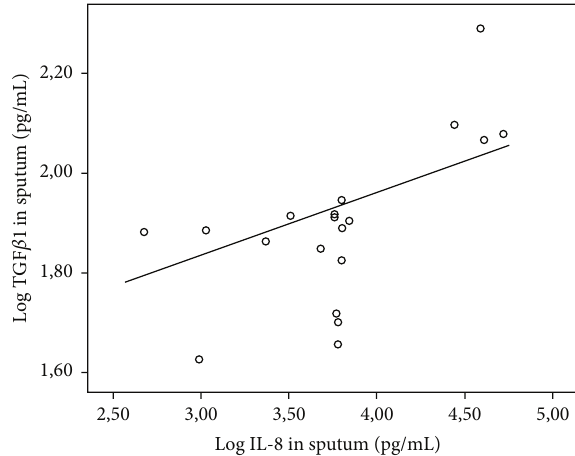
Figure 1: Log 10 TGF 𝛽 1 (pg/mL) in induced sputum in CF patients colonized by either P. aeruginosa, S. aureus, or S. maltophilia plotted as a function of Log 10 IL-8 with linear regression line ( 𝑟 = 0.593 , 𝑃 < 0.007 ).